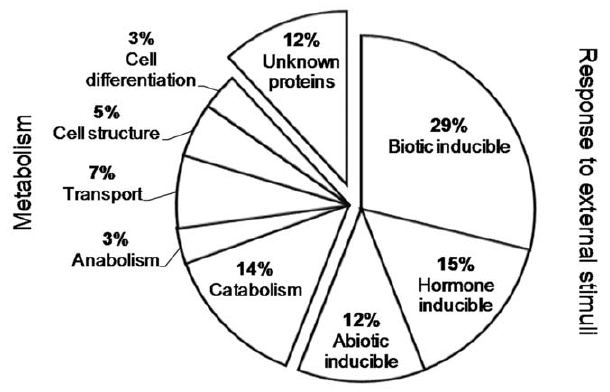
Figure 4. Functions of the 59 Arabidopsis thaliana genes differentially expressed in the presence of earthworms. Functional classification was established according to http://www. arabidopsis.org and the related